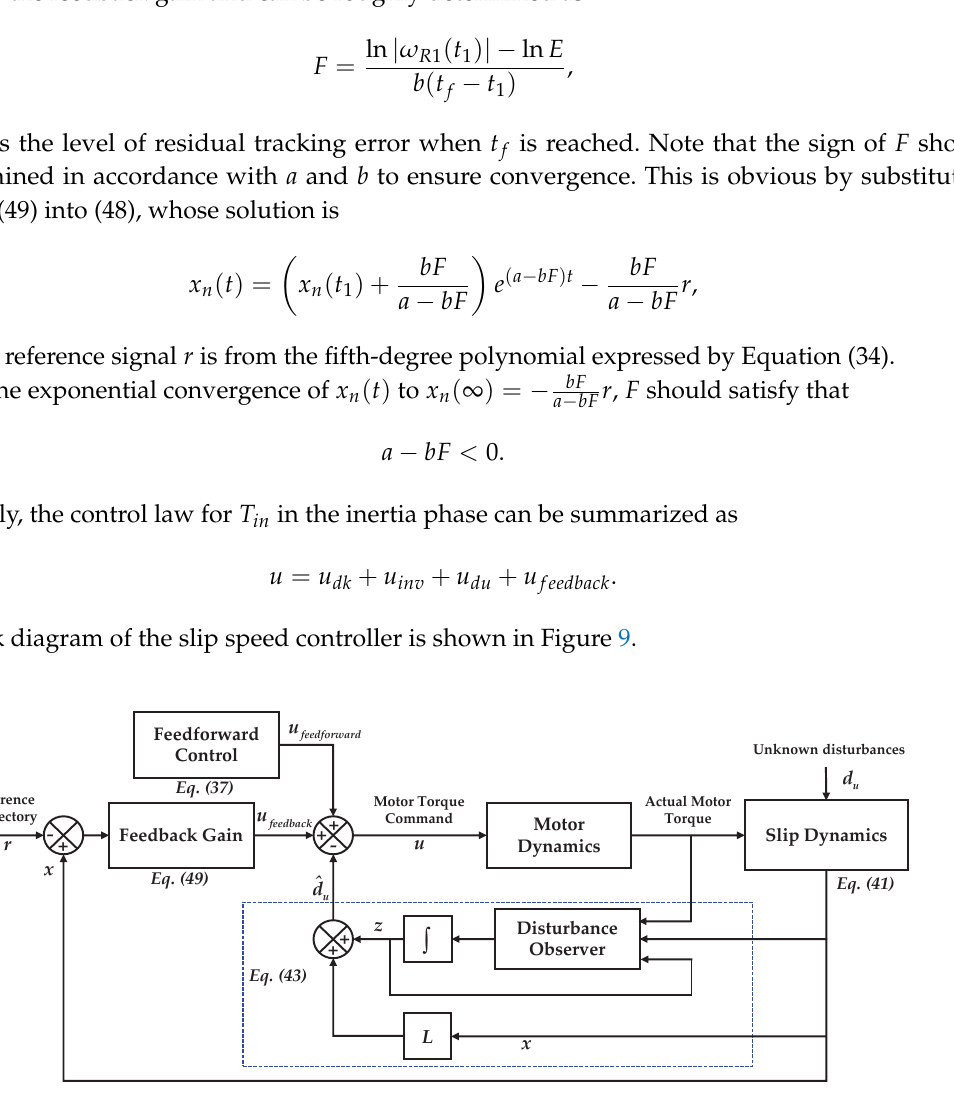
Figure 9. Schematic diagram of the feedforward–feedback slip speed